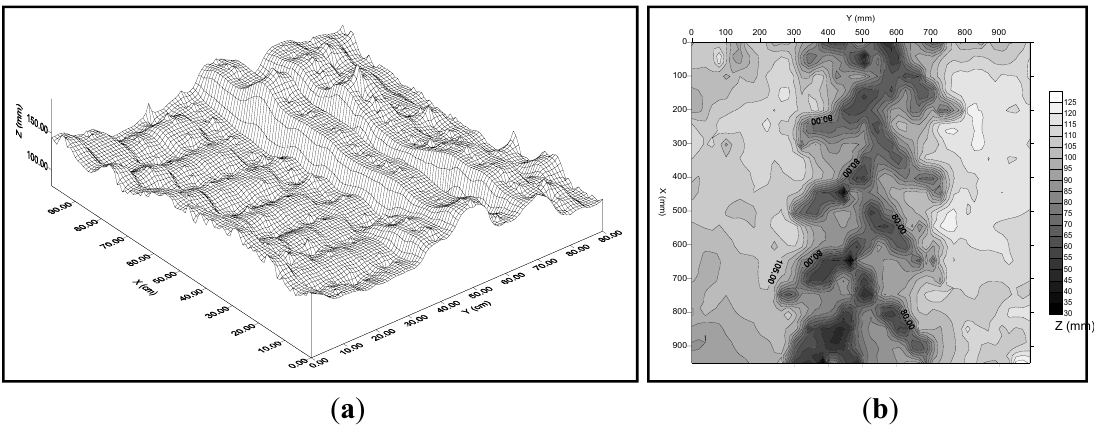
Figure 3. 3D plot of tracked tractor traffic Fiat 82-85 M ( a ) and 2D plot of wheeled tractor traffic E-8110-DT ( b ).